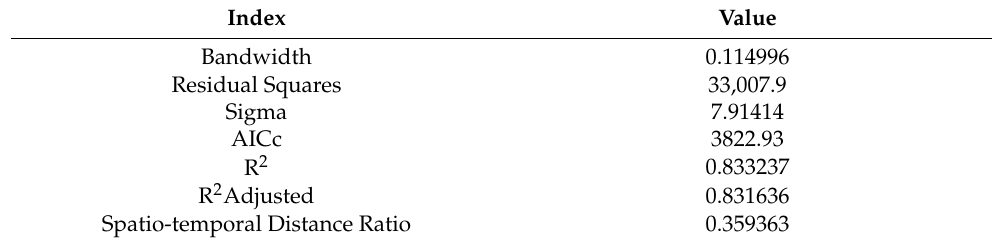
Table A4. GTWR Diagnostic Information.